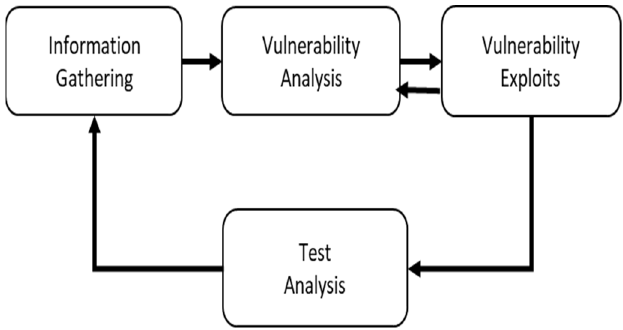
Figure 4. Penetration Testing Stages (Ghanem and Chen 2020).